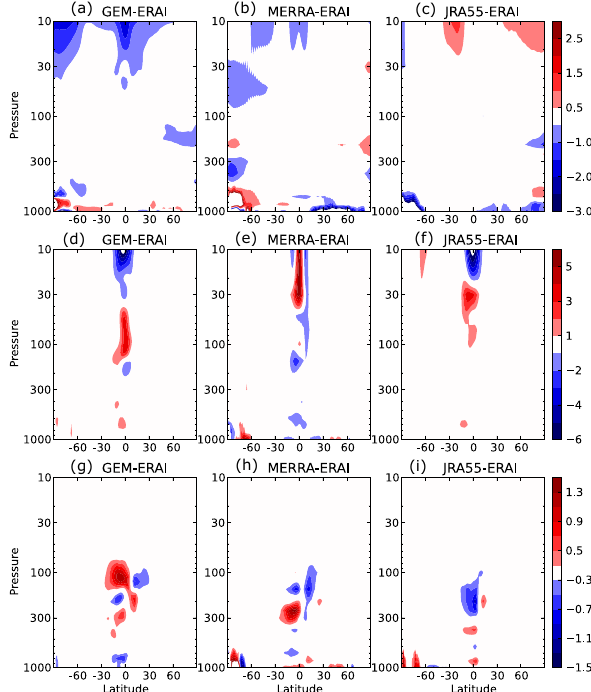
Figure 2. Comparison of GEM-MACH-GHG meteorological anal- yses with other reanalyses for July 2009. Monthly and zonal means of differences with respect to ERA-Interim fields of GEM-MACH- GHG (left column), MERRA (middle column) and JRA55 (right column) are shown for temperature in K (top row), zonal wind in ms − 1 (middle row) and meridional wind in ms − 1 (bottom